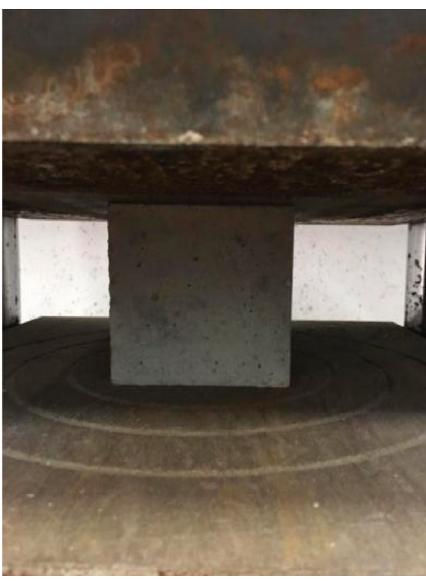
Figure 3: Uniaxial cube compressive